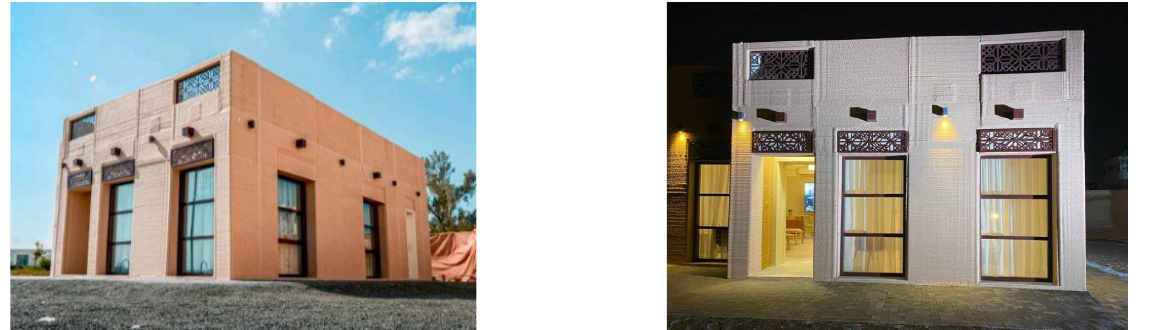
Figure 9. A 3D-printed house in Sharjah Research, Technology and Innovation Park.